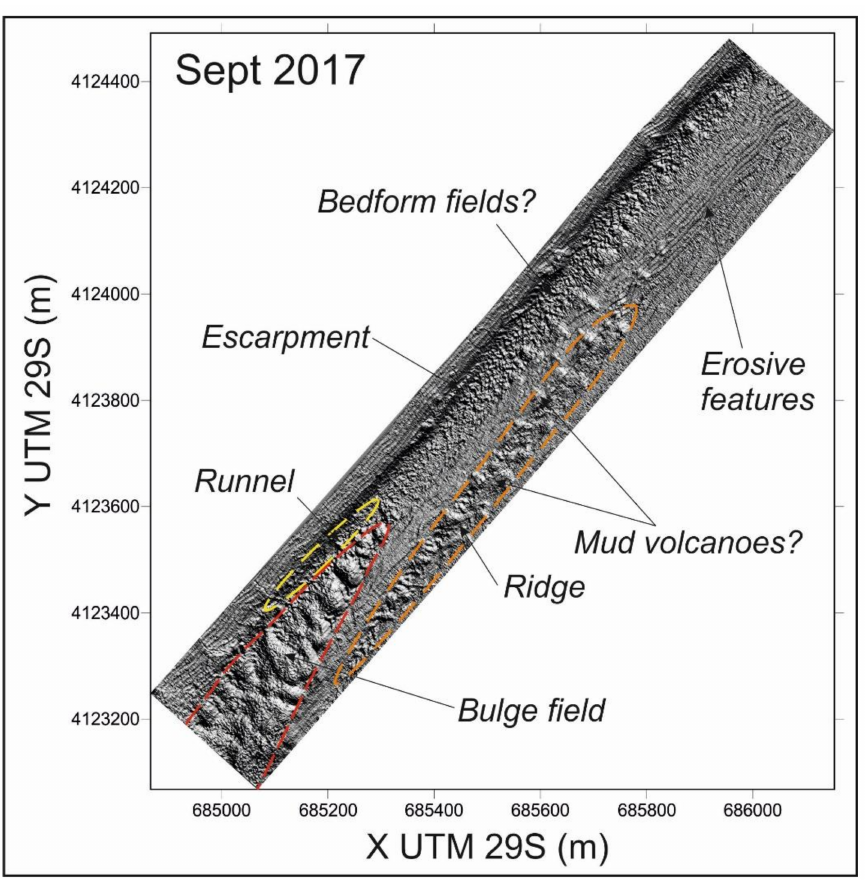
Figure 4. Shaded relief from September 2017 multibeam bathymetric data. Some features are clearly observed, whereas others can only be